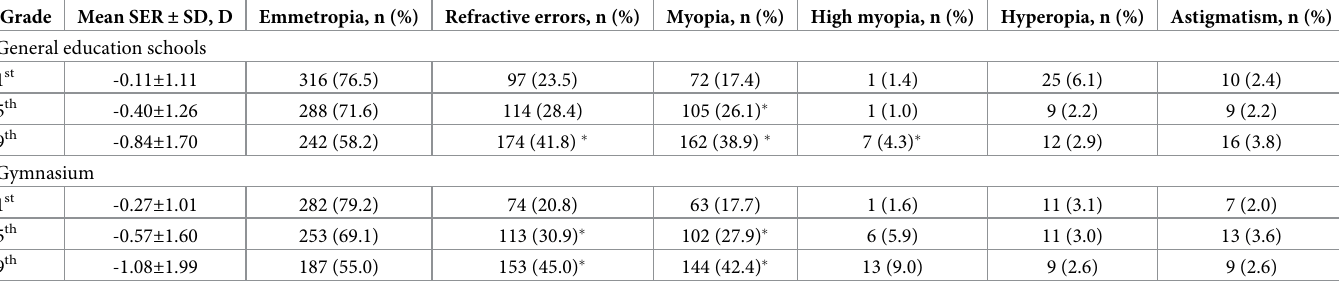
Table 3. The prevalence of refractive errors in students of different grades.